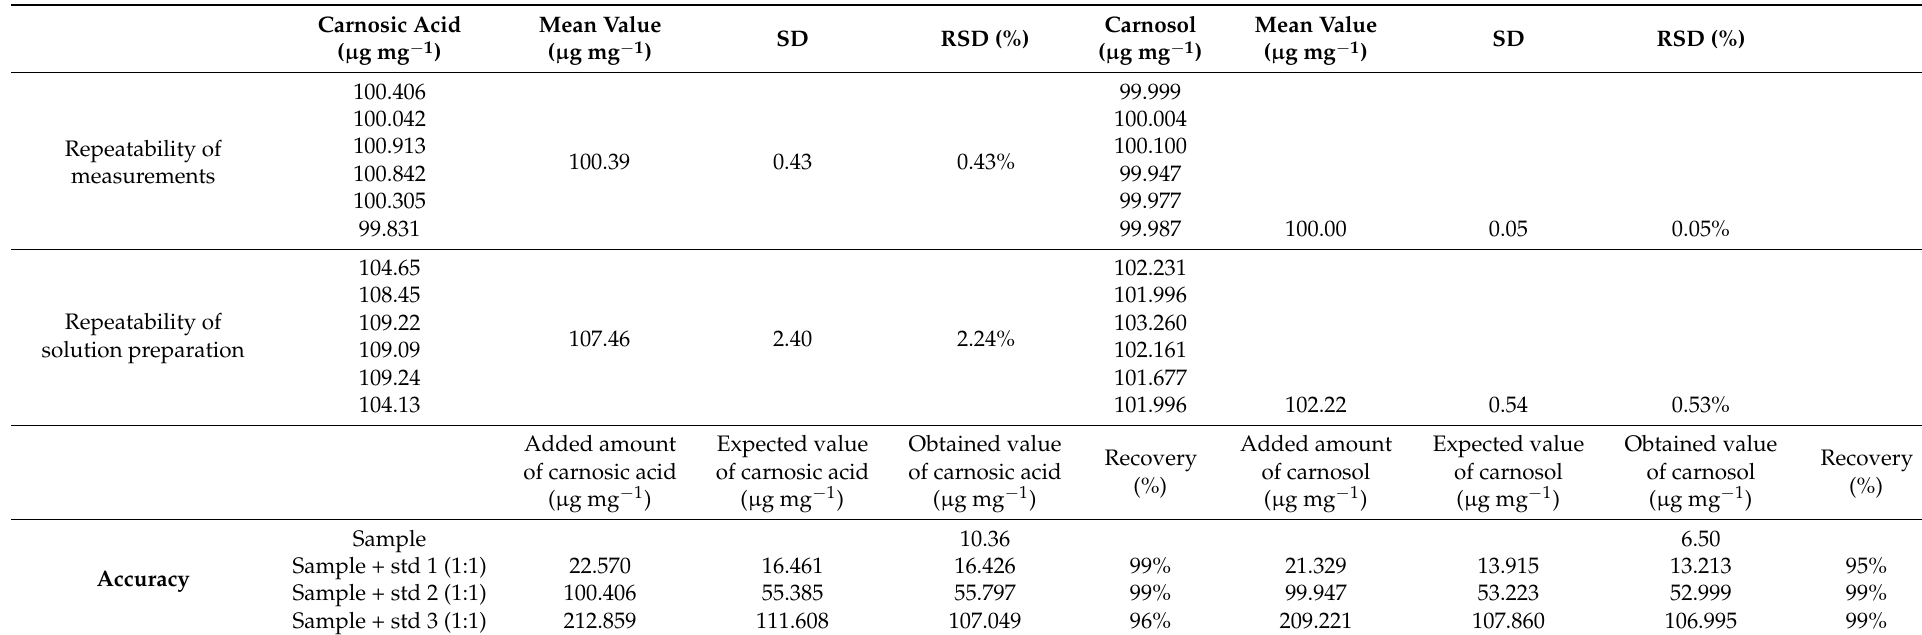
Table A5. HPLC method validation